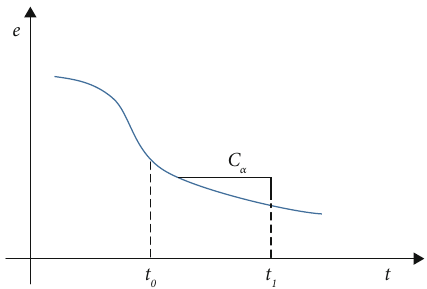
Figure 1: Primary consolidation and secondary consolidation of normally consolidated